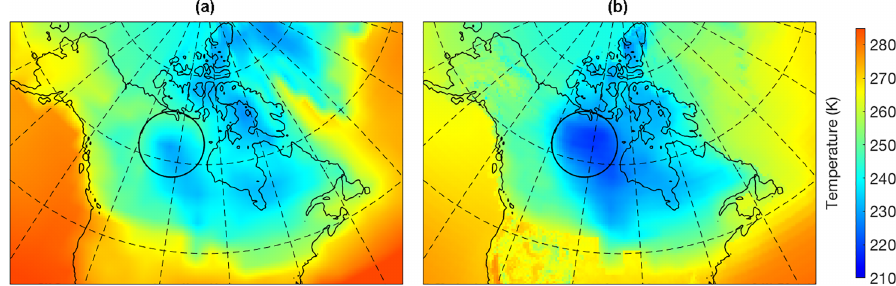
Figure 6. Mean annual surface temperature at the LGM over North America as generated with HadCM3 by Singarayer and Valdes (2010) (a) versus the temperature field generated for these conditions using a constant lapse rate approach (b) . GCM temperatures are substantially higher over the main dome of the ice sheet (area indicated by black